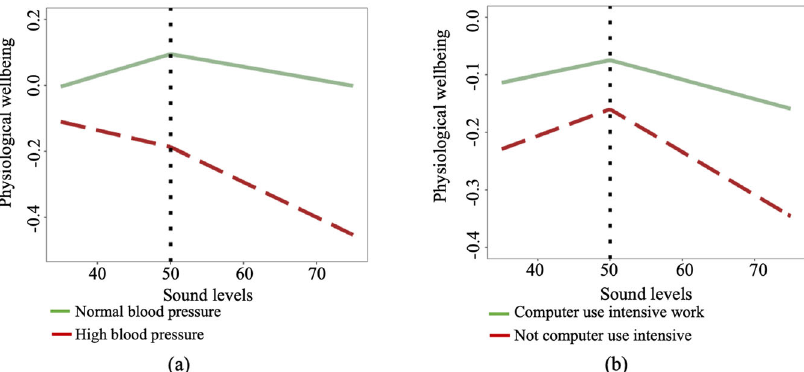
Fig. 3 Interaction plots of the top two person-level variables moderating the sound-wellbeing association. a Green solid line: Normal blood pressure. Red dashed line: High blood pressure. b Green solid line: Computer use intensive work. Red dashed line: Not computer use intensive